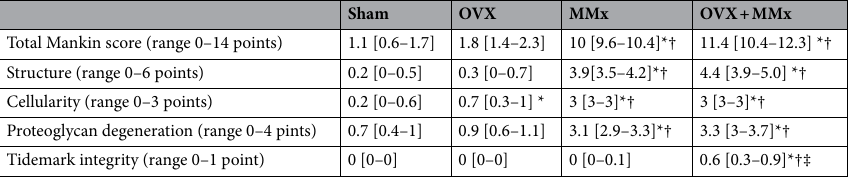
Table 1. Mankin score of knee joints. Values are presented as the means and 95% CIs. *: p < 0.05 compared with the Sham group; †: < 0.05 vs. OVX group; ‡: p < 0.05 compared with the MMx group.